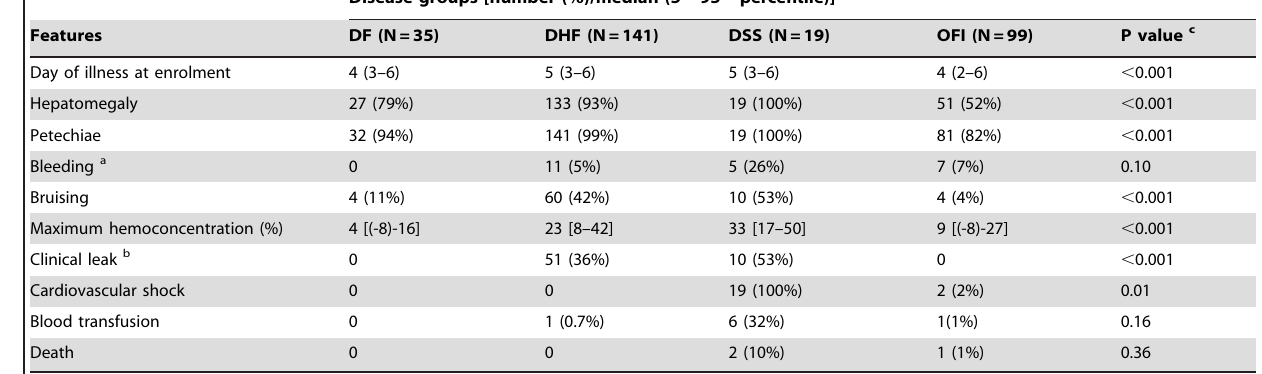
Disease groups [number (%)/median (5 th -95 th percentile)]